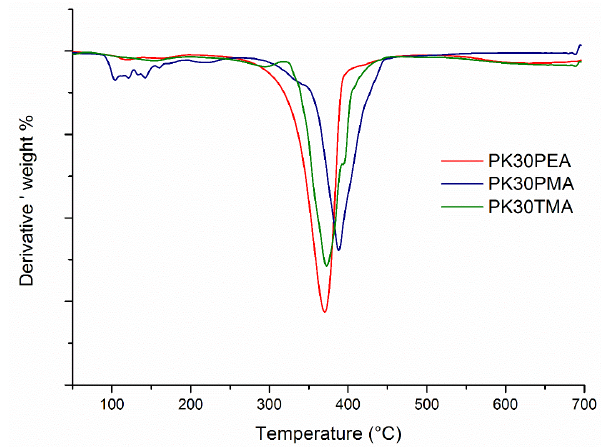
Figure 1. Comparison of the first derivative thermogravimetric analysis (TGA) curves of the different functionalized PKs.